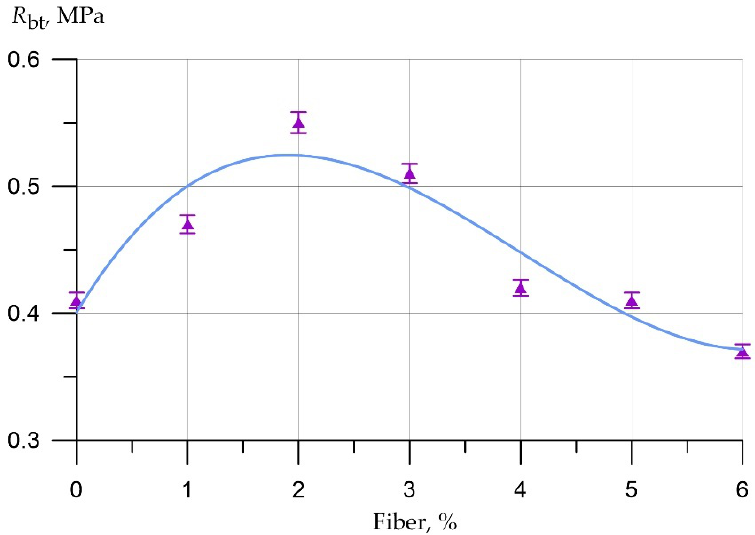
Figure 5. Results of experimental studies of tensile strength in bending (R bt ) of fiber foam concrete samples at various dosages of polypropylene fiber.